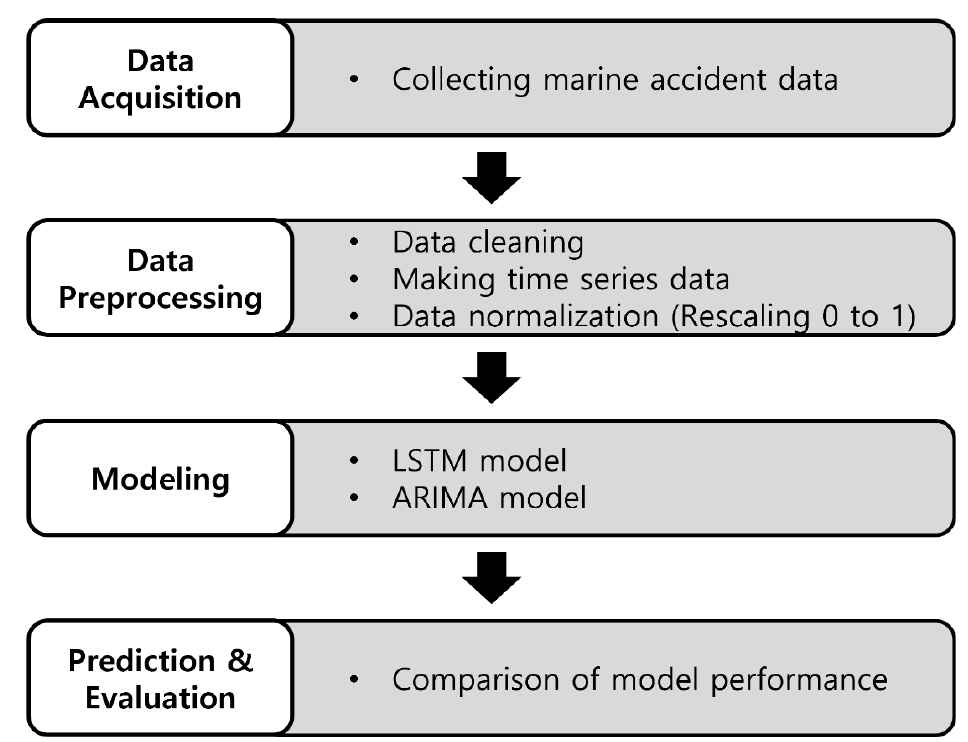
Figure 1. Workflow for predicting the frequency of marine accidents.